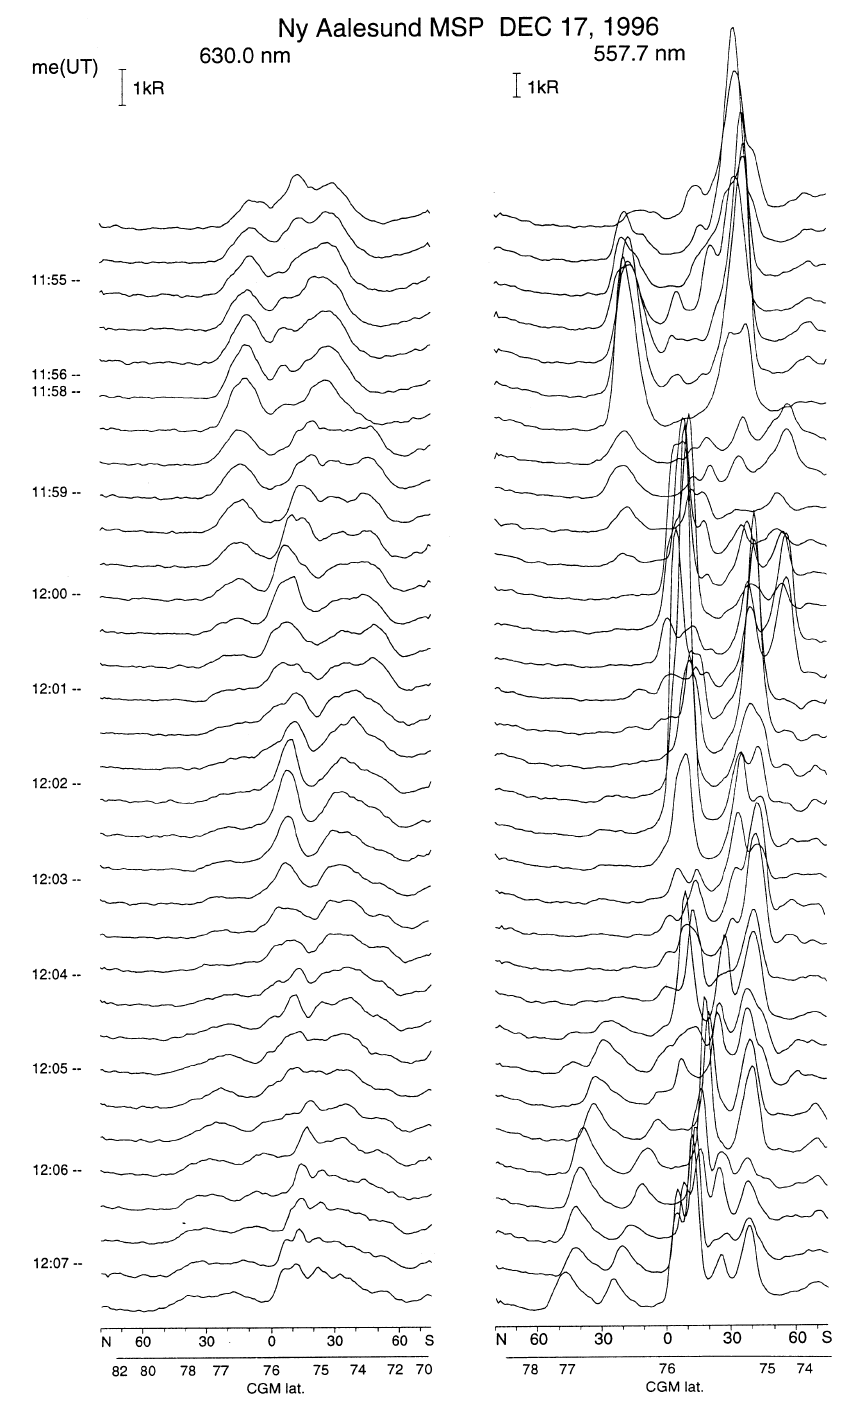
Fig. 5. Meridian scanning photometer data from 17 December 1996 for 630.0 nm and 557.7 nm channels with corresponding